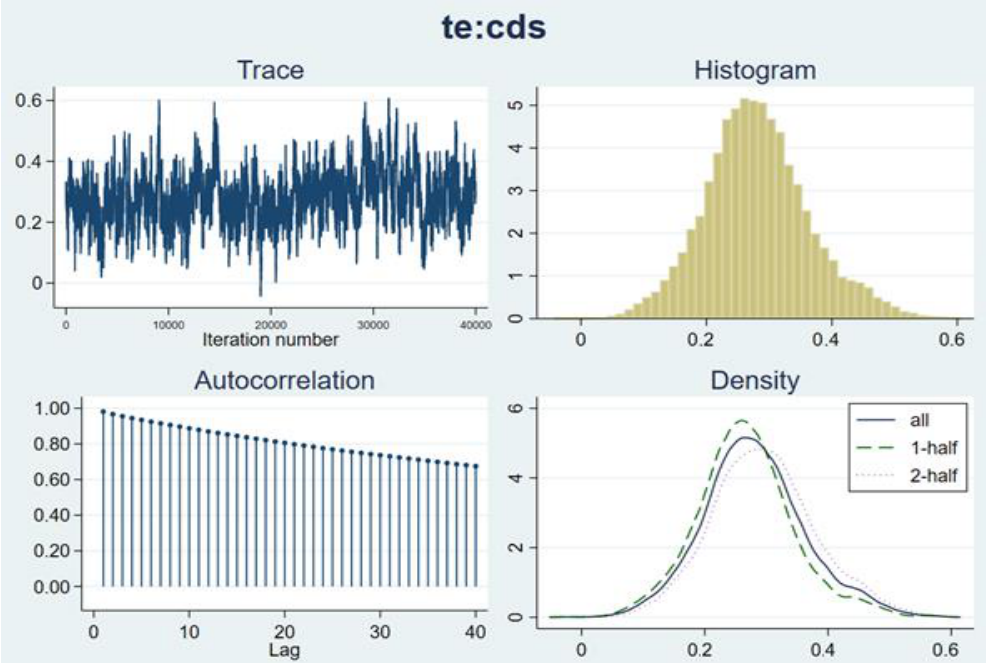
Figure 2. The result of testing the convergence of the MCMC chain corresponding to the regression coefficient of the digital transformation variable (CDS) . Source: calculated from STATA 16.0 soft- ware.